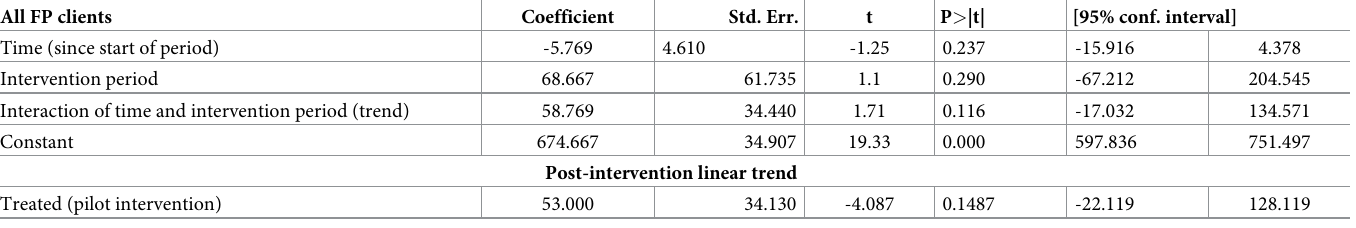
Table 9. Results of interrupted time series regression, monthly totals of injectable clients in the ten pilot intervention facilities from September 2017 to November 2018, Tanzania 2018. All FP clients